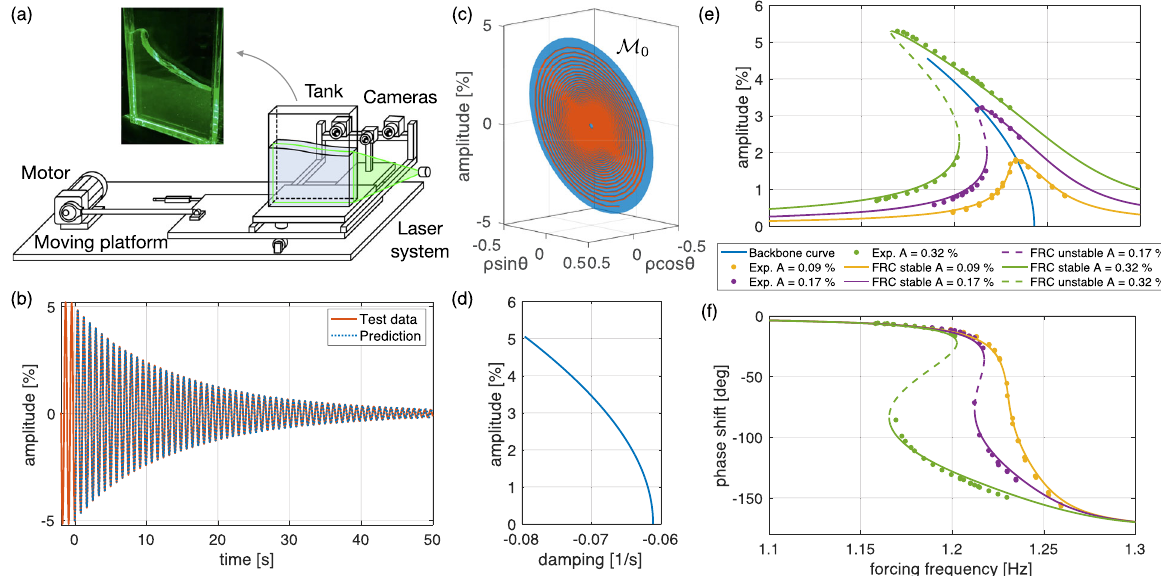
Fig. 6 Data-driven nonlinear reduced-order model on the slowest SSM of fl uid sloshing in a tank. a Setup for the sloshing experiment 55 . b Decaying model-testing trajectory and its reconstruction from an unforced, SSM-based model c The geometry of the embedded SSM d Nonlinear damping α ( ρ ) from the SSM-reduced dynamics e , f Closed form, SSM-based predictions of the FRCs and the response phases ψ 0 for three different forcing amplitudes (solid lines), with their experimental con fi rmation superimposed